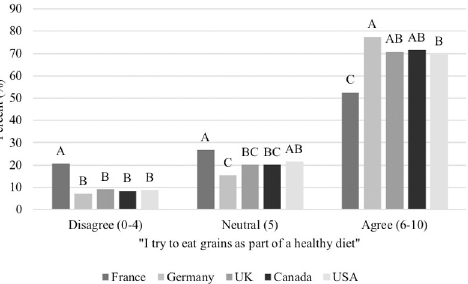
Fig 2. Score assigned to the statement, “I try to eat grains as part of a healthy diet” between respondents in each country (n = 3,298). Proportions in the same category that do not share a common letter are significantly different at P <